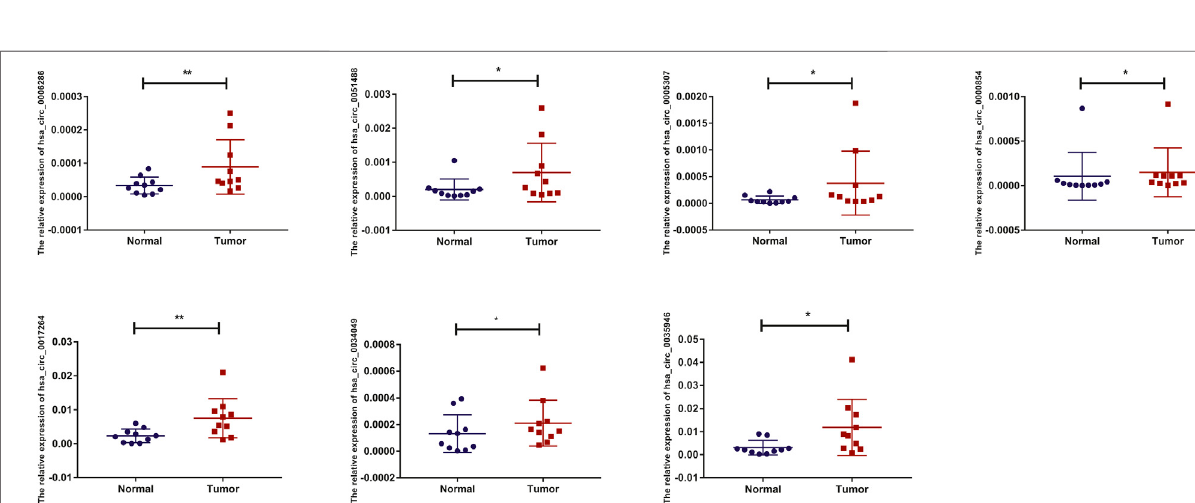
Frontiers in Genetics |